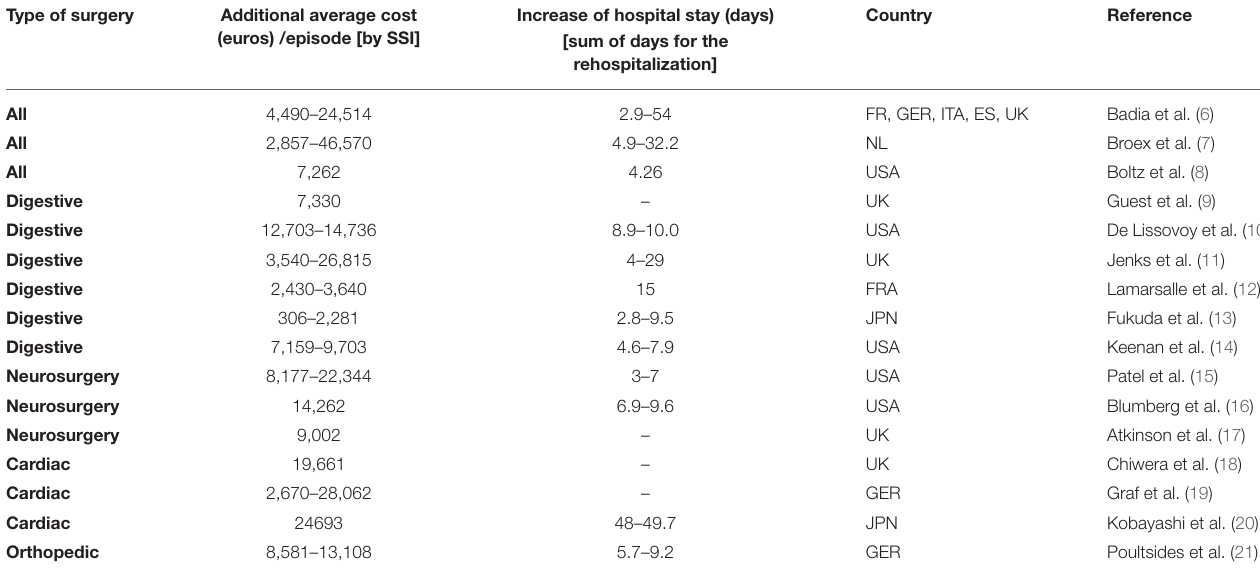
TABLE 1 | Increase in duration and additional costs associated with surgical site infections